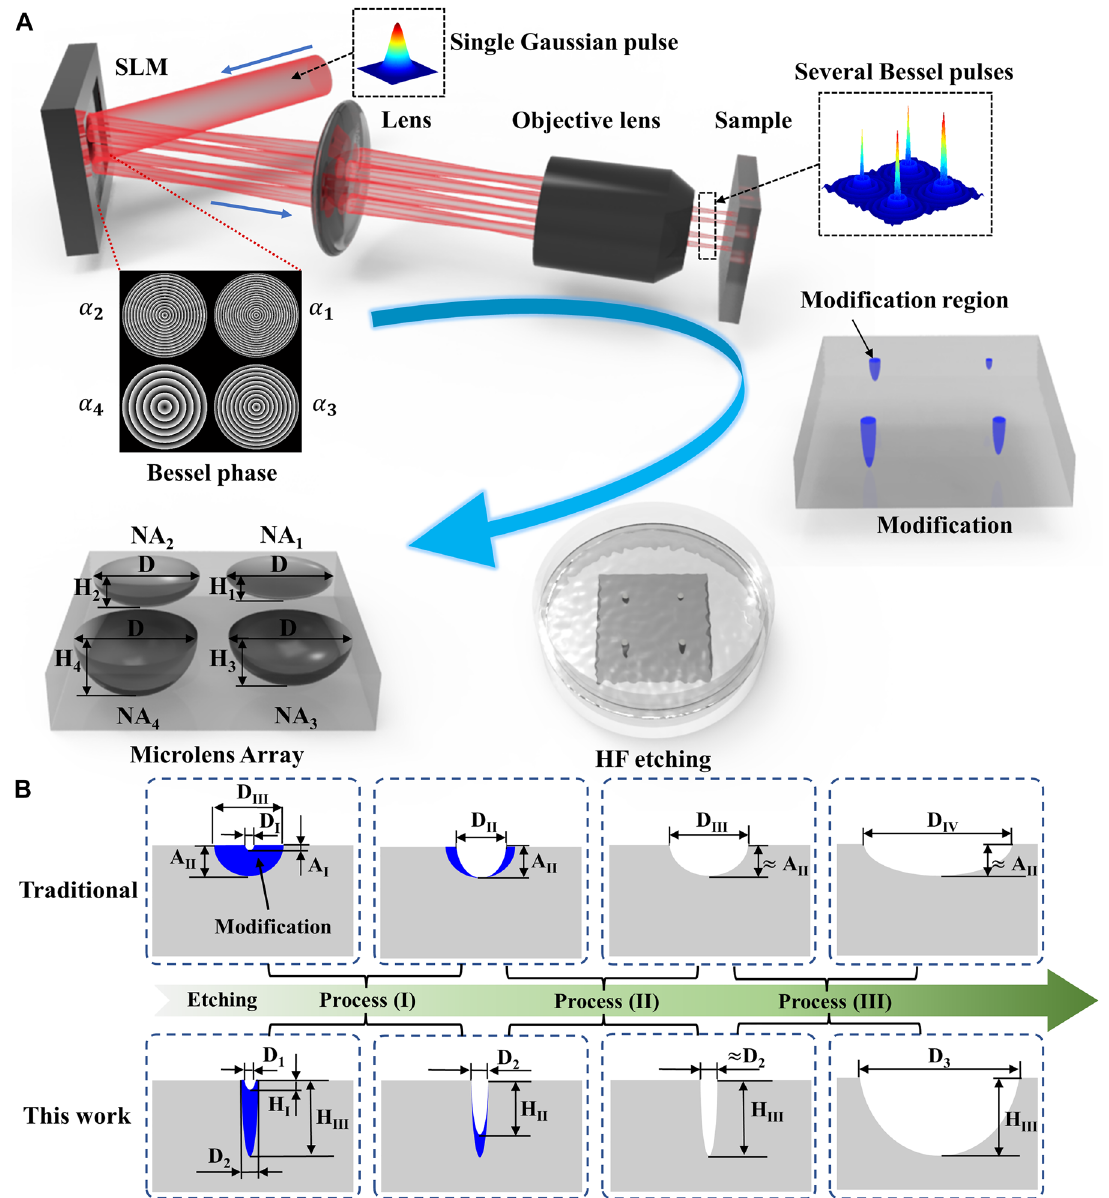
Figure 1: Schematic of the design and fabrication of an MLA with multiple NAs and analysis of etched procedure after modification. (A) Schematic of the design and fabrication of an MLA with multiple NAs. (B) Schematic comparison of traditional technology and proposed technologyintheetchingprocedure.Theblueregionrepresentsthemodificationregion,thewhitedefaultregionrepresentsthestructureregion. D represents the structure diameter. A and H represent the height of the structure fabricated by the traditional technology and the proposed technology,